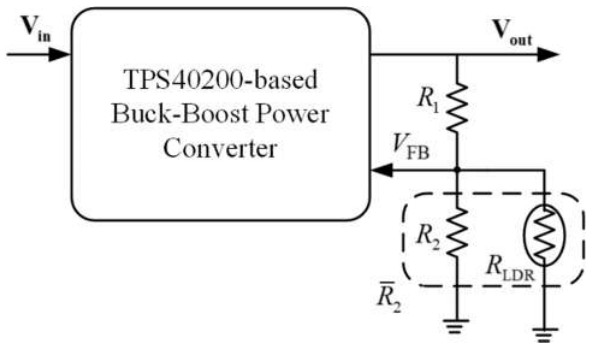
Figure 4. Digital variable resistor based voltage divider.